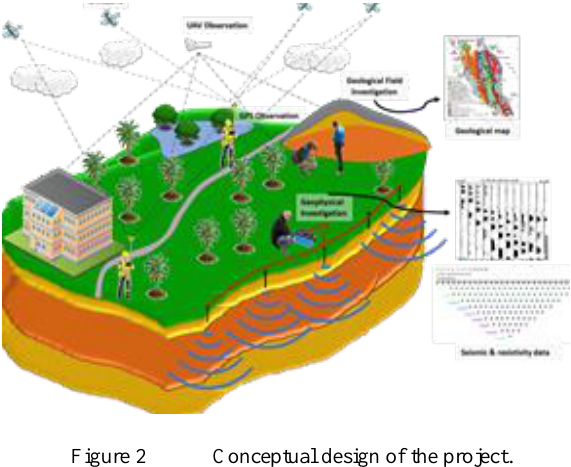
Figure 2 Conceptual design of the project.